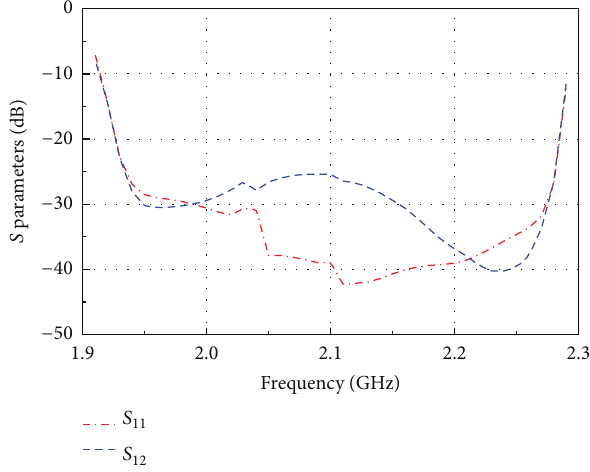
Figure 3: Simulated 𝑆 -parameters of the horn